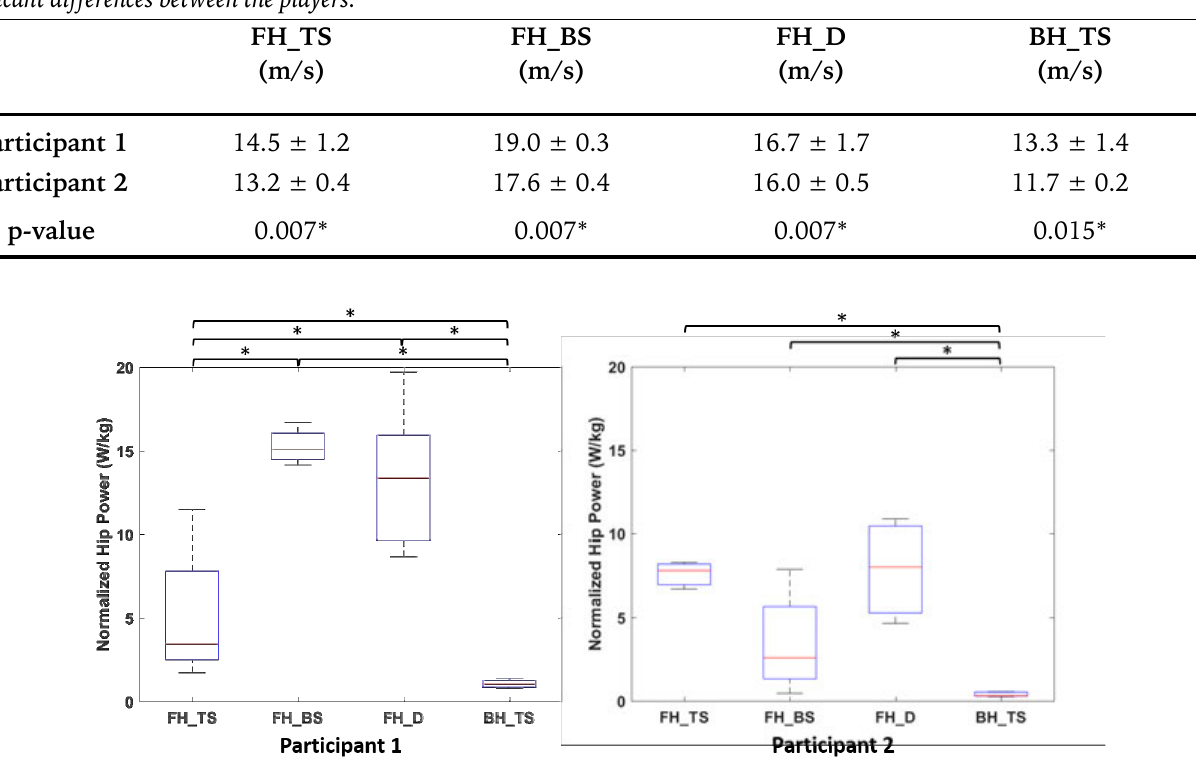
Figure 3 . Boxplot of the maximal normalized hip joint mechanical power for the four activities (5 trials by boxplot) of each participant. The * means that there were significant differences between the